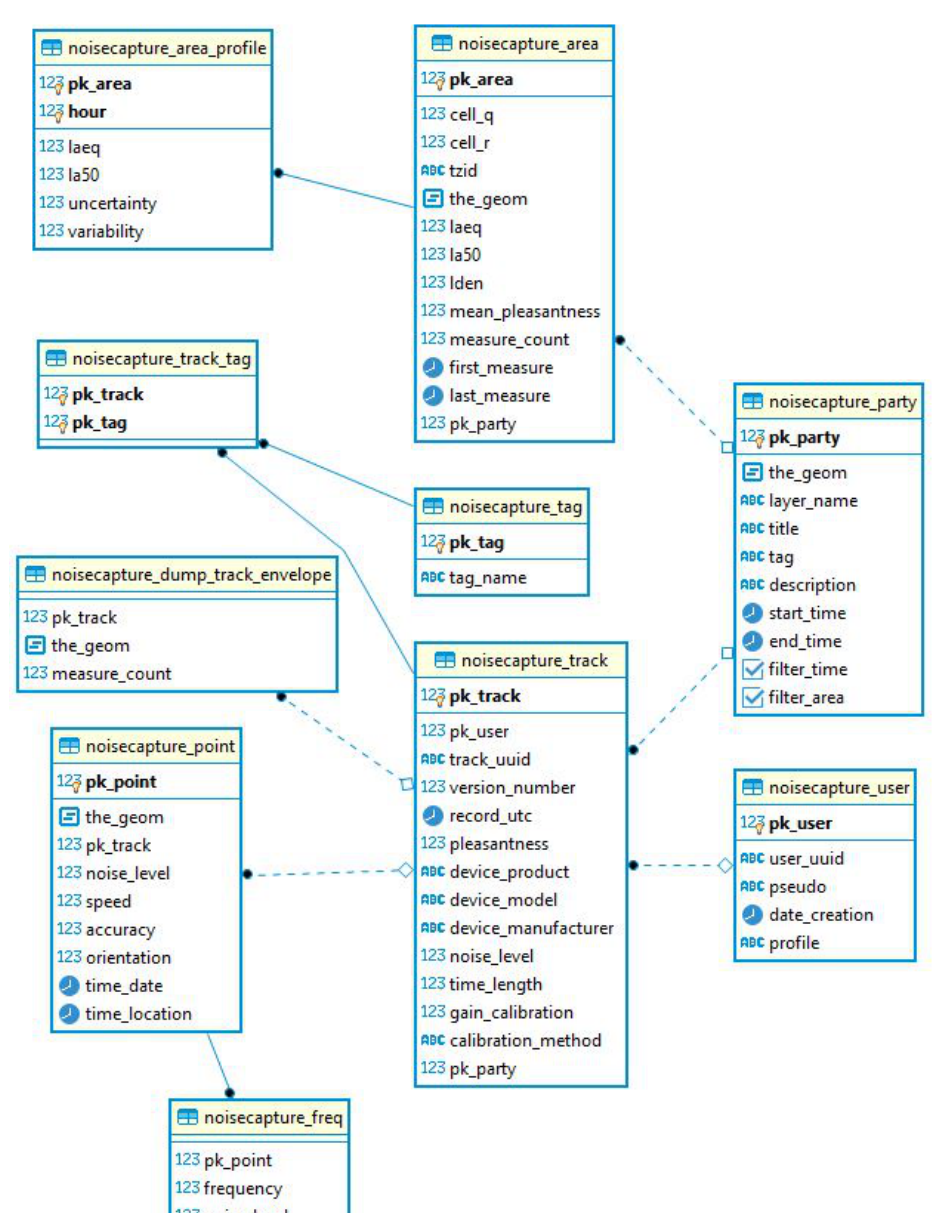
Figure 5. Entity relation diagrams (ERD) of the NoiseCapture PostGIS database. The type of each field in the tables is mentioned: ‘123’ for ‘float’ values, ‘ABC’ for ‘text’ chains, ‘timestamptz’ for time stamp date, ‘ (cid:3)(cid:88) ’ for ‘boolean’ value. The ‘key’ yellow symbol is used to display primary keys of the table, whose corresponding names are displayed in